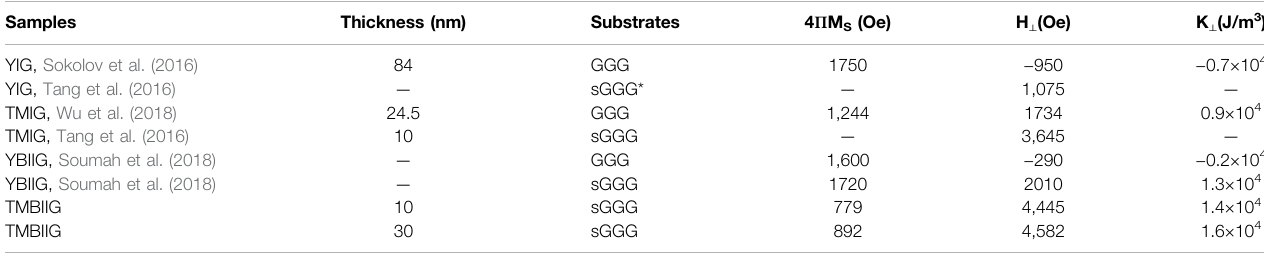
TABLE 1 | Comparison of magnetic anisotropy parameters based on the recent works. Partial reference data have been converted from the SI units to the CGS units in the article. It should be pointed out that the sGGG* listed in the table has a larger lattice constant than the substrate used in this work. Samples